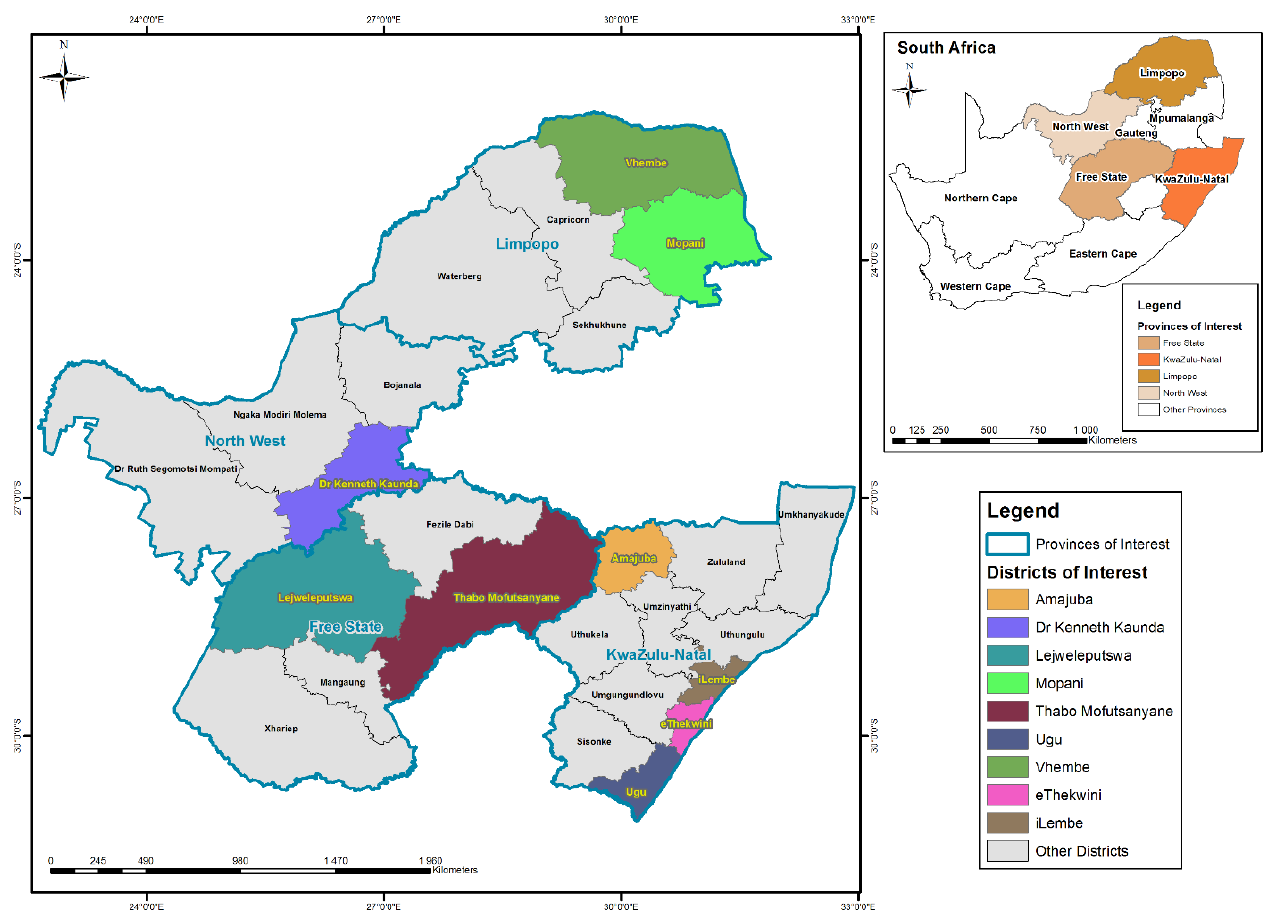
Figure 2. Map of the selected district municipalities. Source [15].